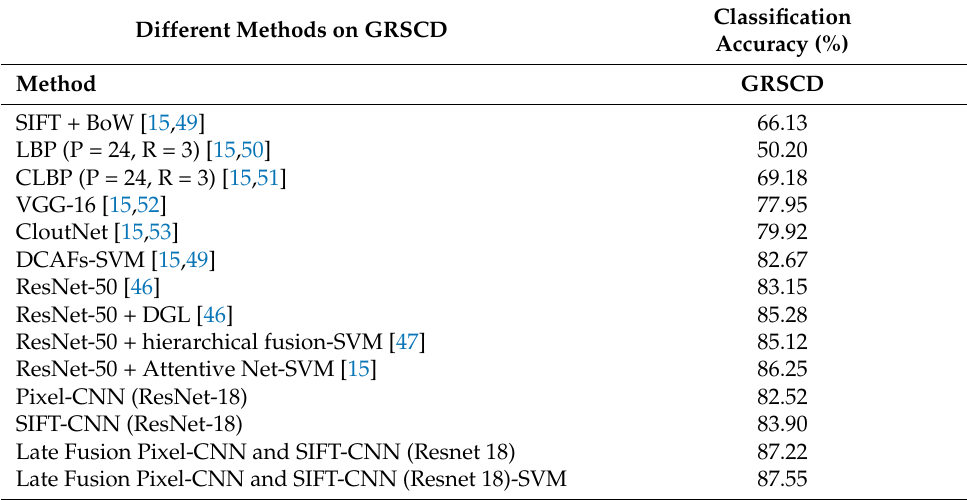
Table 2. Classification results for the ground-based image-cloud database (TJNU-GRSCD). Different Methods on